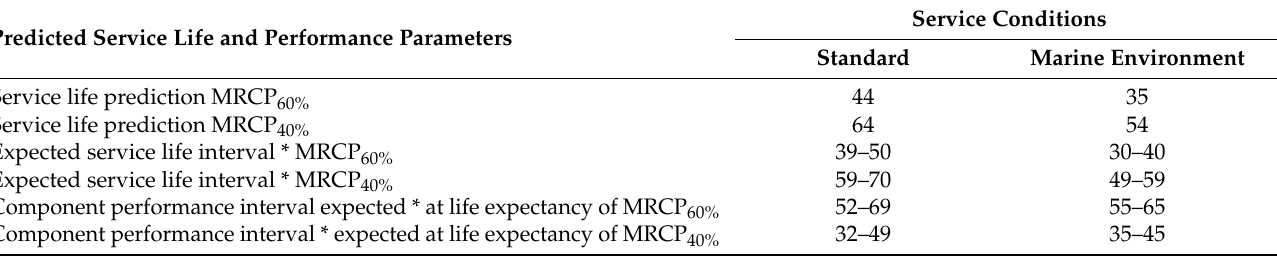
Table 6. Service life expectancy, PSLI, and predicted component performance interval, PCPI, of wet-fixed stone cladding.